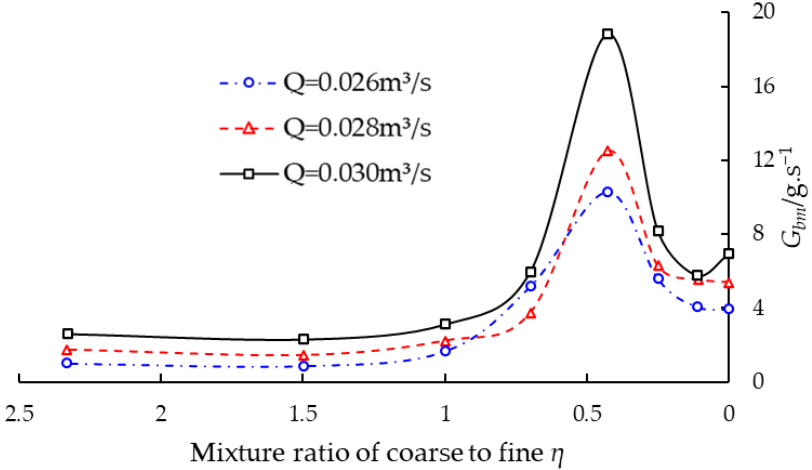
generally decrease, follow a similar trend, and present a humped curve.